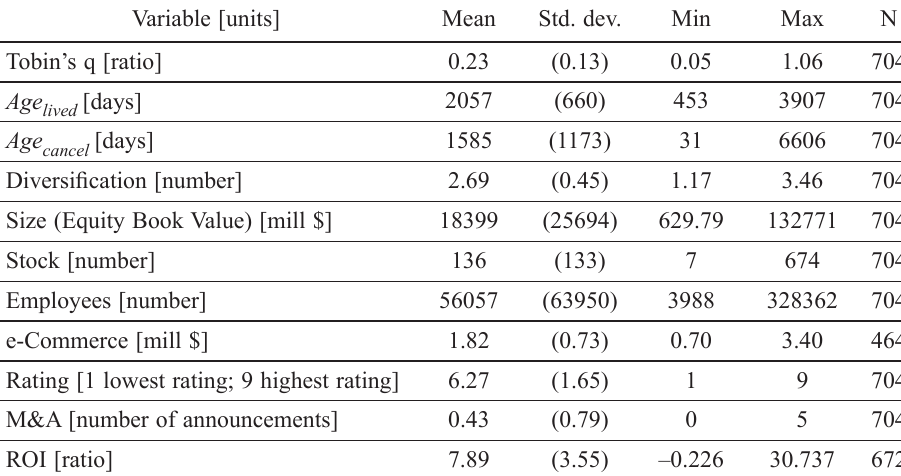
Table 1. Summary